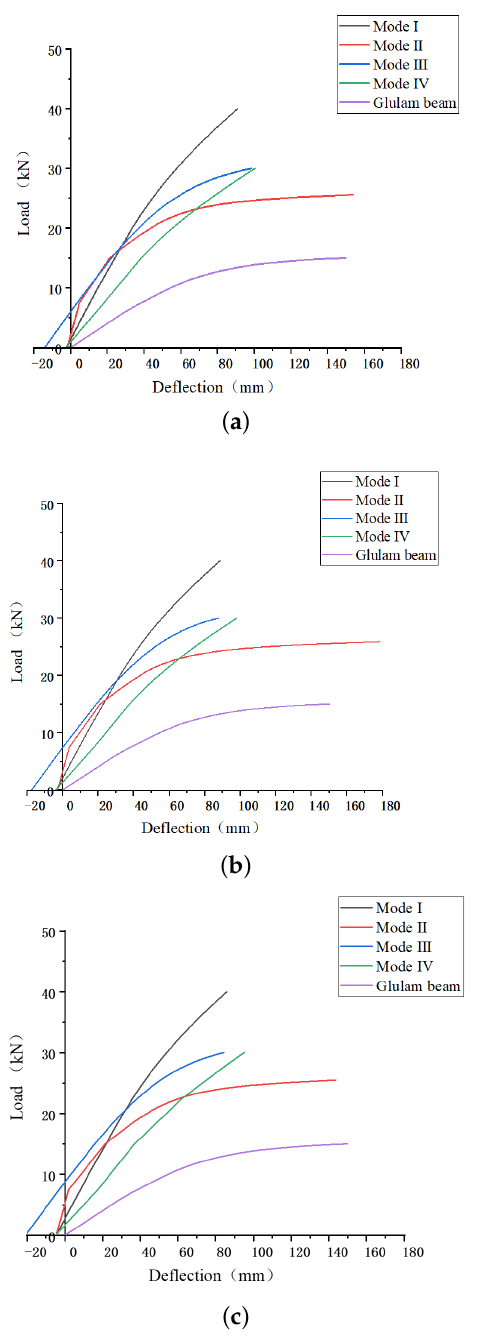
Figure 10. Load-deflection curves with various initial mid-span top prestress. ( a ) One MPa initial mid-span top prestress, ( b ) 1.5 MPa initial mid-span top prestress and ( c ) 2 MPa initial mid-span top